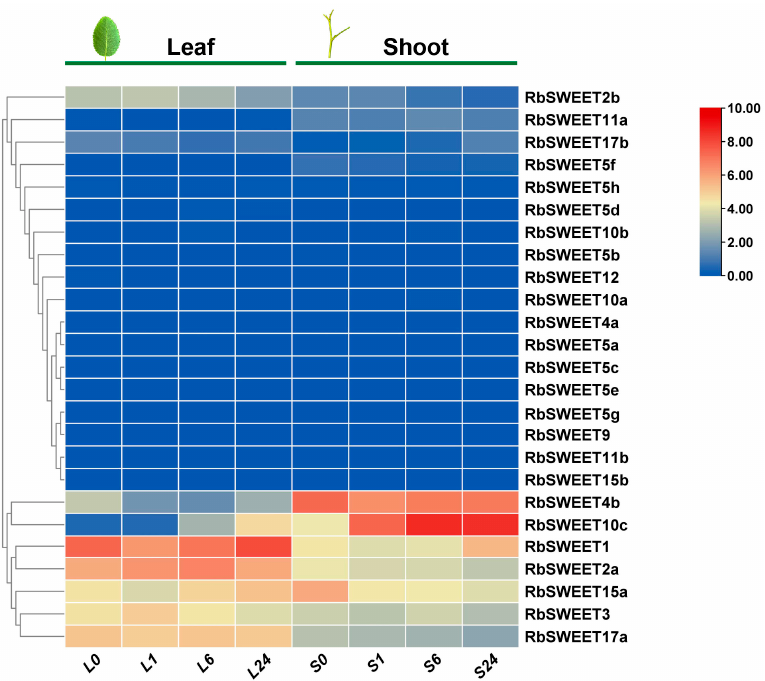
Figure 6. Transcriptional levels of RbSWEET genes after cold stress in R. beggeriana . Heatmap showing expression patterns of RbSWEET genes in the leaves and shoots treated at 4 ◦ C for 0 h, 1 h, 6 h, and 24 h, represented by L0, L1, L6, L24, and S0, S1, S6, S24, respectively. Expression levels are shown as the log 2 FPKM values obtained from the RNA-Seq data.